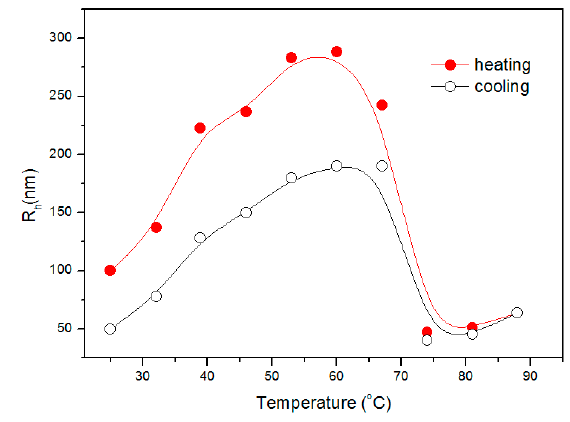
Figure 10. Temperature dependence of R h for 0.6 g·L − 1 mPEG-maleic rosin solution collected during one heating and cooling cycle.